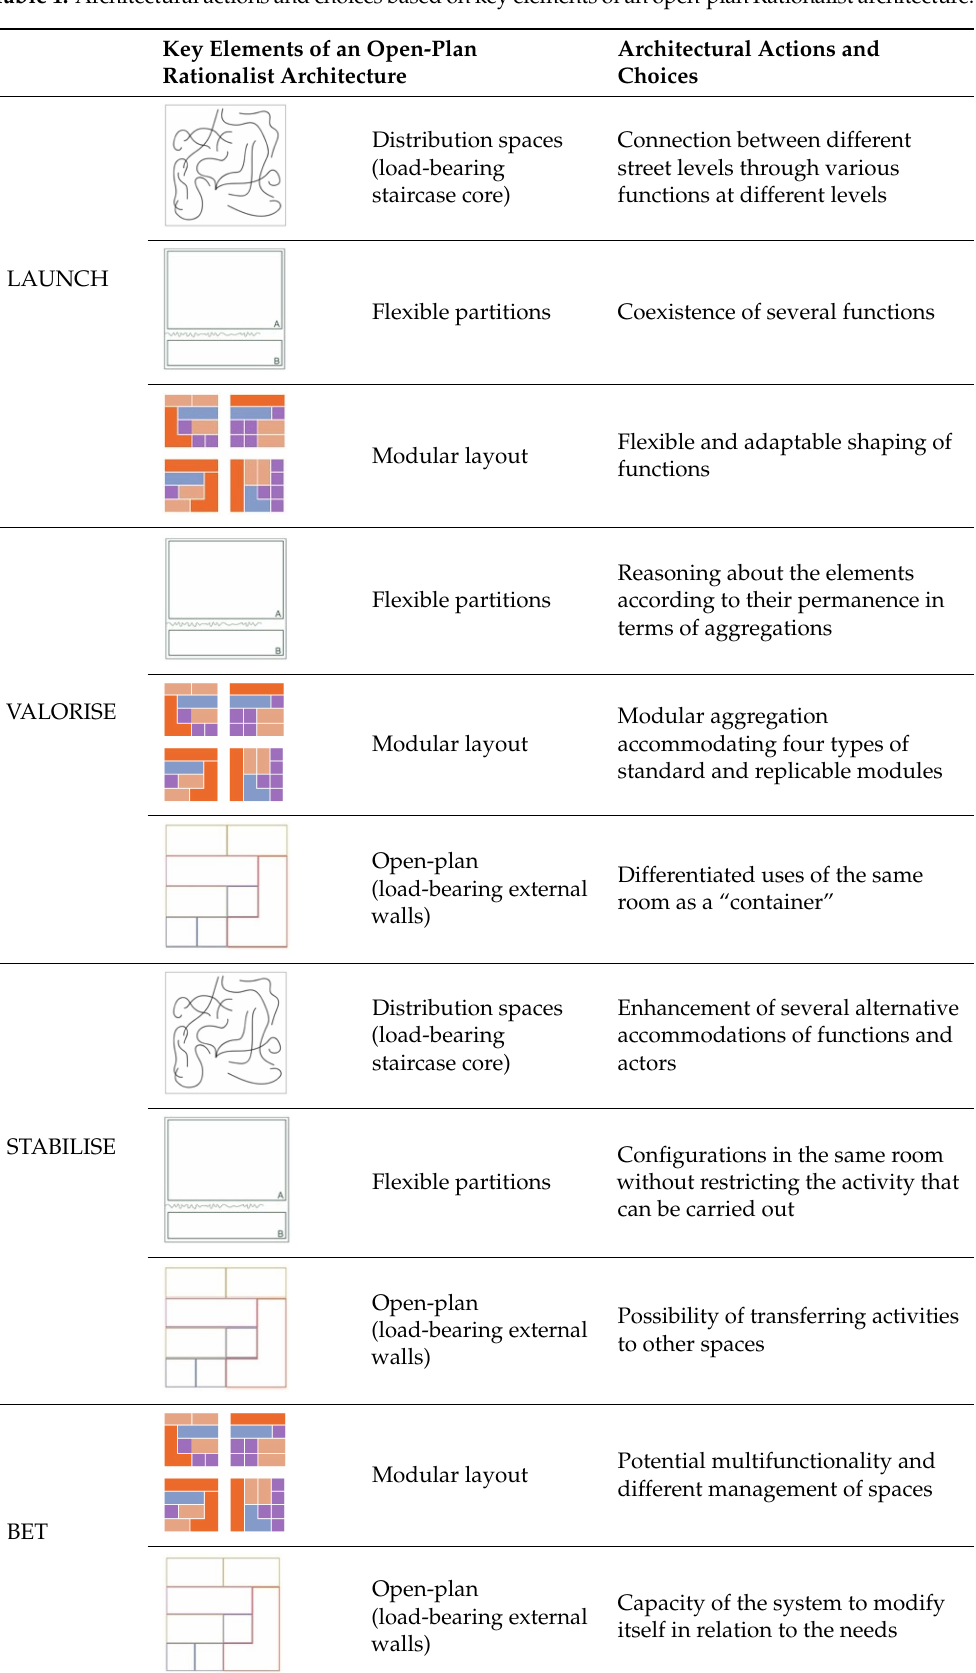
Table 1. Architectural actions and choices based on key elements of an open-plan Rationalist